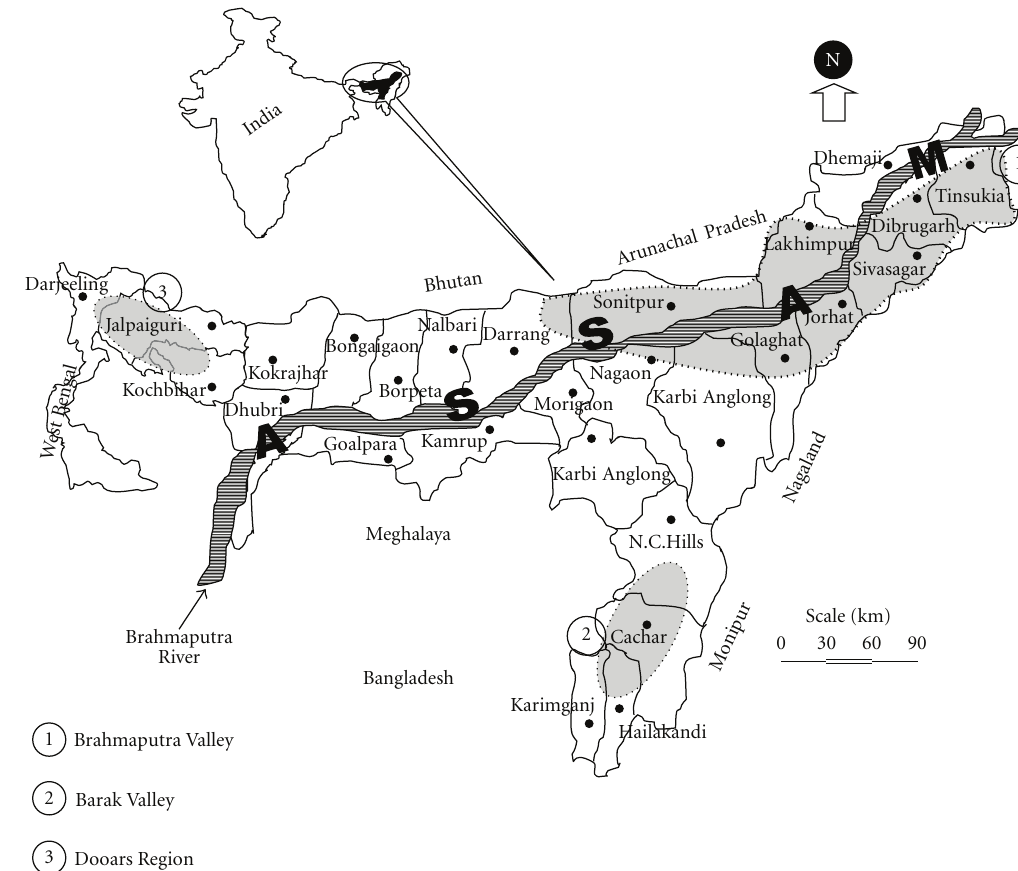
Figure 2: Map showing major tea growing areas of Northeast